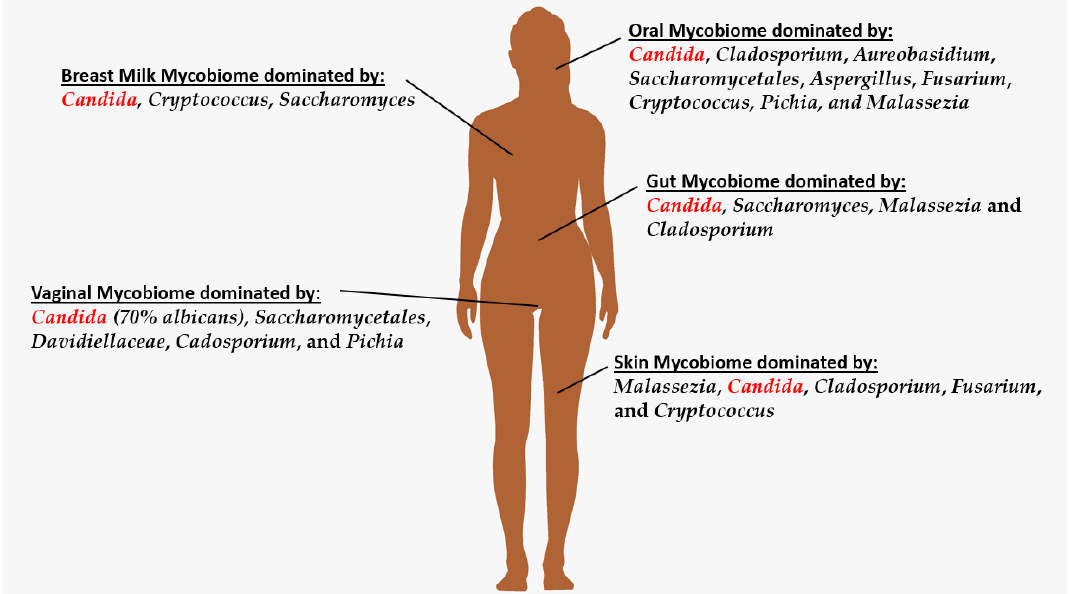
Figure 1. Summary of the dominant fungi present in the oral, breastmilk, skin, gut, and vaginal mycobiomes, with Candida , specifically Candida albicans , the most abundant (in red font) of the fungi native to the human body.